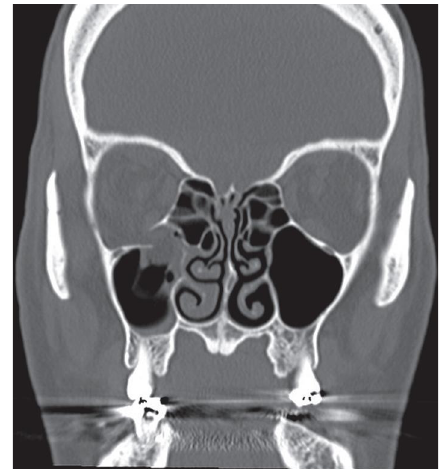
Figure 5: Open globe injury in a 63-year-old man. Axial unen- hanced CT image showing concurrent inferior orbital fracture.